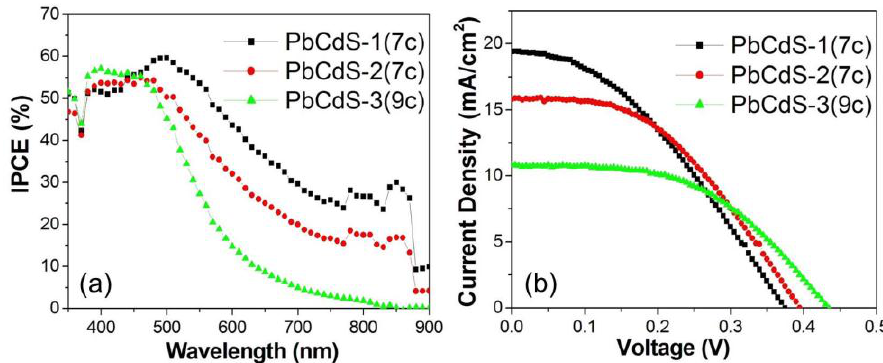
Figure 6. ( a ) IPCE spectra and ( b ) I–V curves of QDSCs employing PbCdS-1 (seven SILAR cycles), PbCdS-2 (seven SILAR cycles), and PbCdS-3 (nine SILAR cycles).